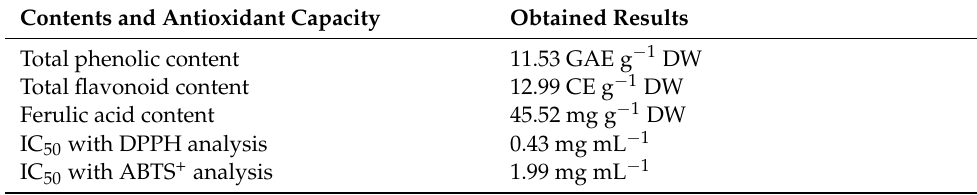
Table 4. A summary of the results of the total phenolic content, total flavonoid content, ferulic